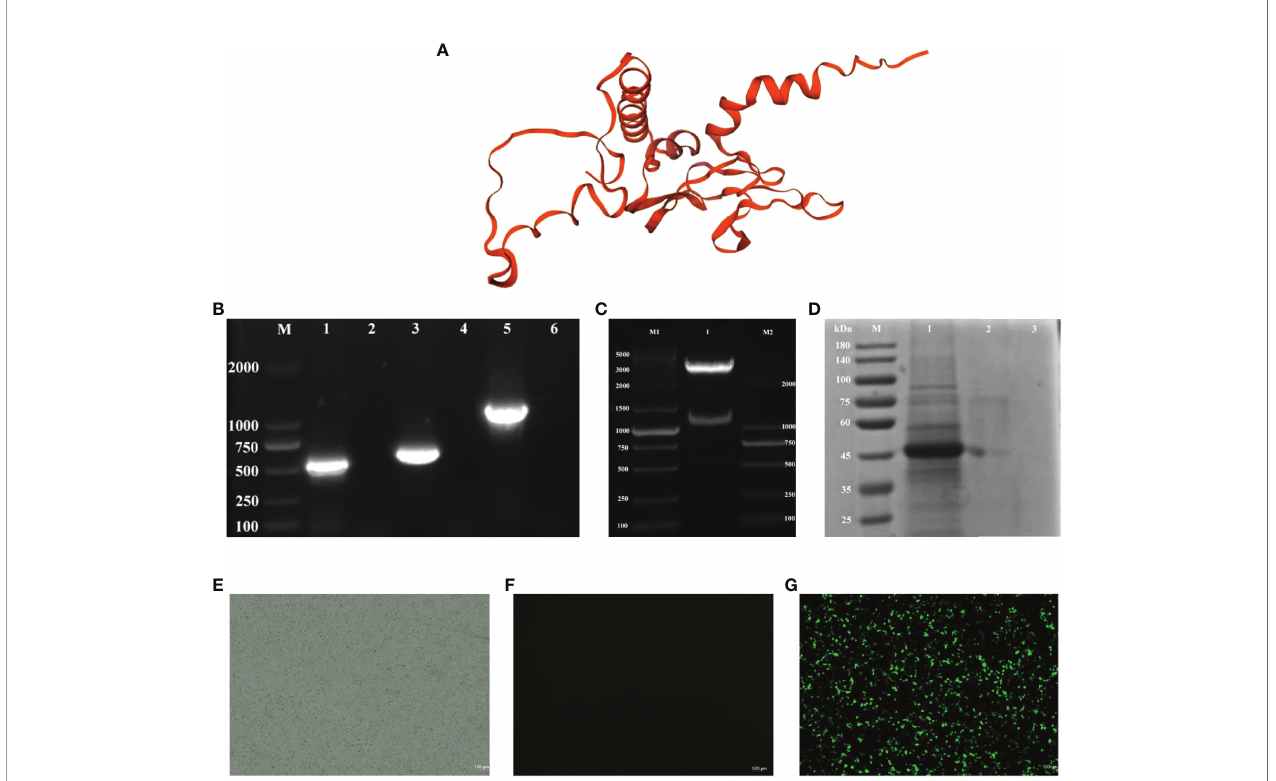
FIGURE 1 | Identi fi cation of pPG-612-CK6-G /L.casei 393 and the protein expression. (A) Three-dimensional structures of recombinant CK6 and G proteins (B) Electrophoresis plots of ampli fi cation of different target genes, line 1: the G gene strip; line 3: the CK6 gene strip; line 5: the recombinant CK6-G strip; line 2, 4 and 6: blank control; (C) Double digestion electrophoresis plots of recombinant plasmids, 1: recombinant plasmid double digestion strip; M1: DNA marker DL5000, M2: DNA marker DL2000; (D) SDS-PAGE identi fi cation of protein expression of CK6-G gene, line 1: the pPG-612-CK6-G /L.casei 393 after induction; line 2: the uninduced pPG-612-CK6-G /L.casei 393; 3: blank control; M: 10-190 kDa protein marker (E) Indirect immuno fl uorescence map of the blank group. (F) Indirect immuno fl uorescence map of the control group. (G) Indirect immuno fl uorescence plot of the experimental